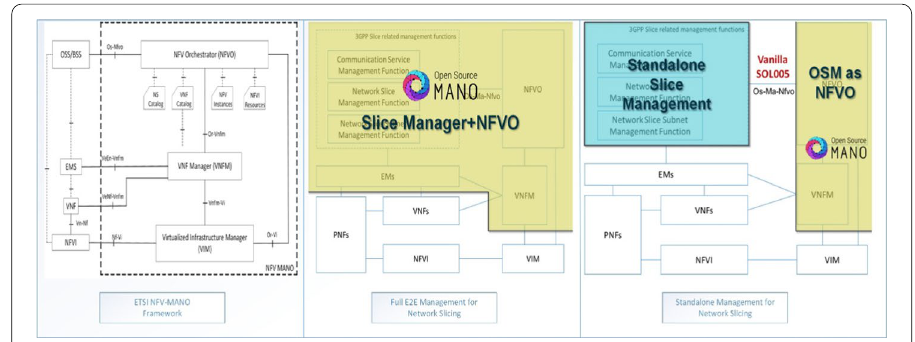
Fig. 3 ETSI NFV‑MANO framework and OSM slicing implementation technique [12]. This figure presented the ETSI NFV‑MANO framework that is used to described network virtualization and the OSM slicing implementation technique. The OSM slicing implementation can be the full E2E management for network slicing and the Standalone management for network